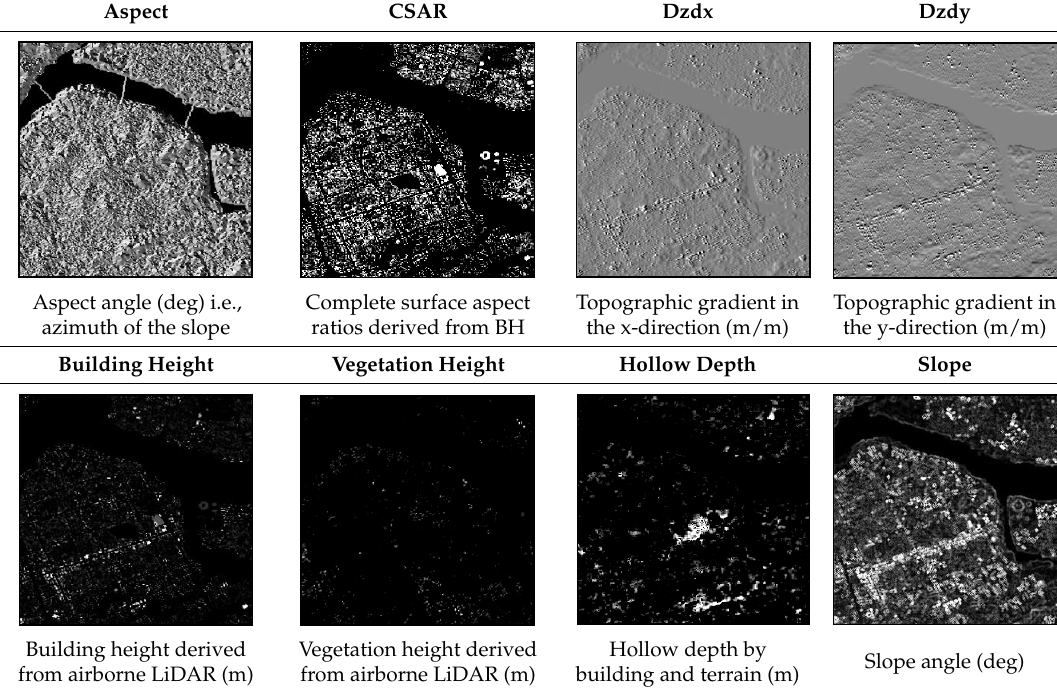
Table 2. Urban surface characteristic parameters. Data source: National Geographic Information Institute (NGII, Korea). Aspect CSAR Dzdx Dzdy